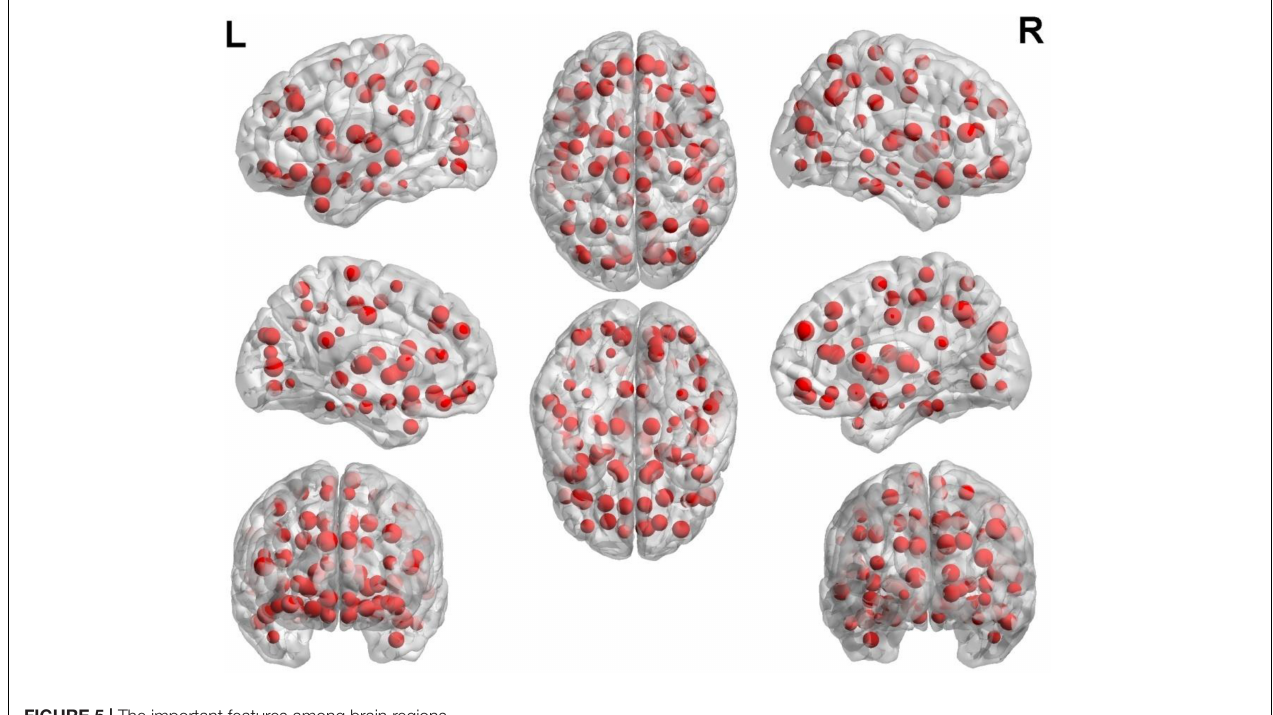
FIGURE 5 | The important features among brain regions.